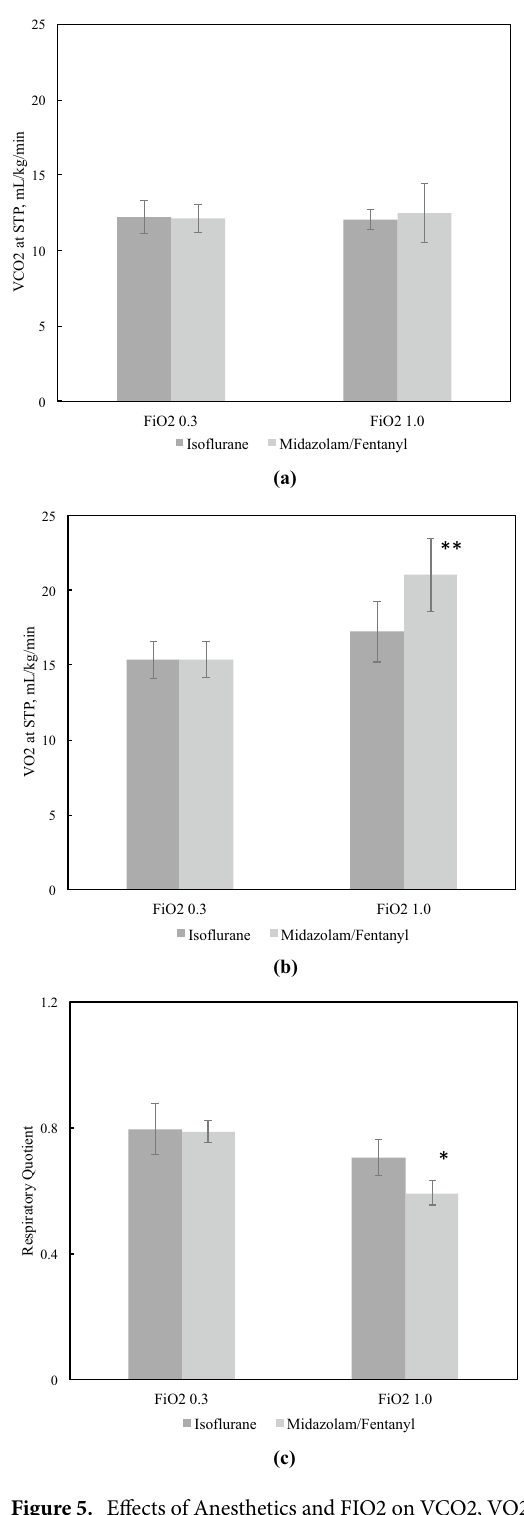
Figure 5. Effects of Anesthetics and FIO2 on VCO2, VO2, and RQ. ( a ) There were no significant differences in VCO2 between the FIO2 0.3 group and the FIO2 1.0 group. ( b ) VO2 increased at FIO2 1.0, which was more remarkable when intravenous anesthetics were used. ( c ) RQ of the intravenous anesthetic group was significantly lower at FIO2 1.0 than FIO2 0.3, while there was no significant change in the inhaled anesthetic group between FIO2 0.3 and FIO2 1.0. *, p < 0.05; **, p <